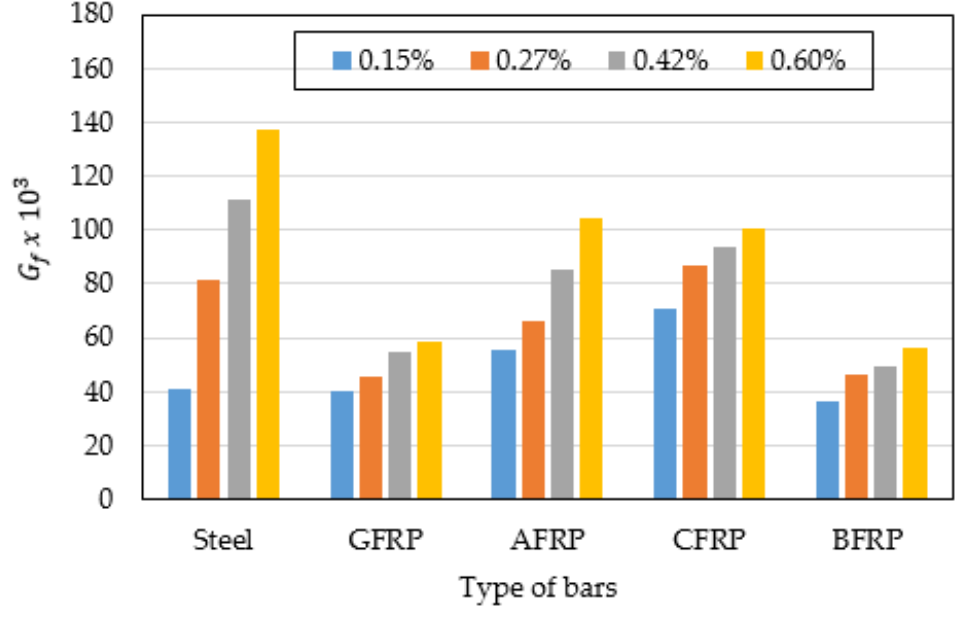
Figure 8. Fracture energy vs. Type of bars.